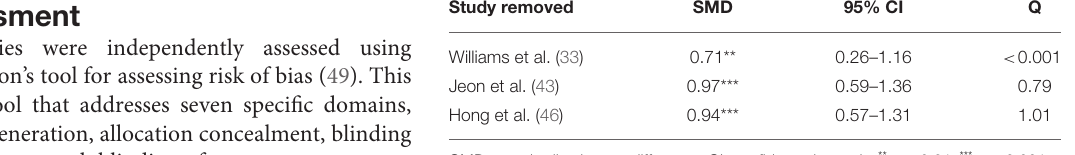
Frontiers in Psychiatry |